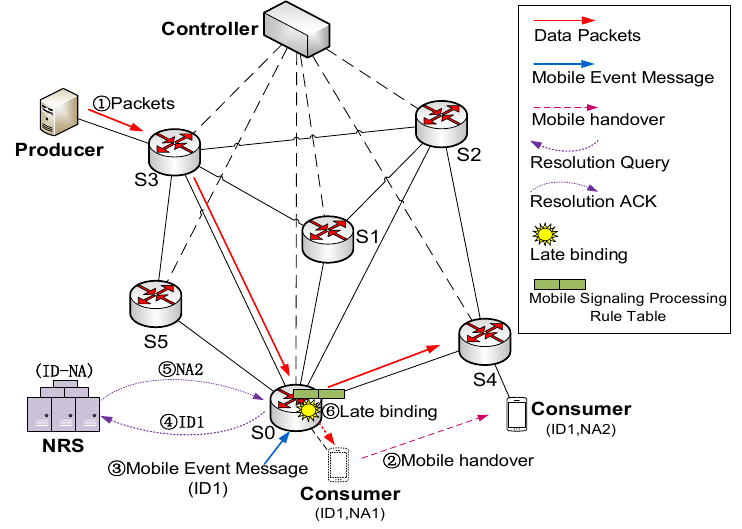
Figure 5. Mobile scenario as an example.